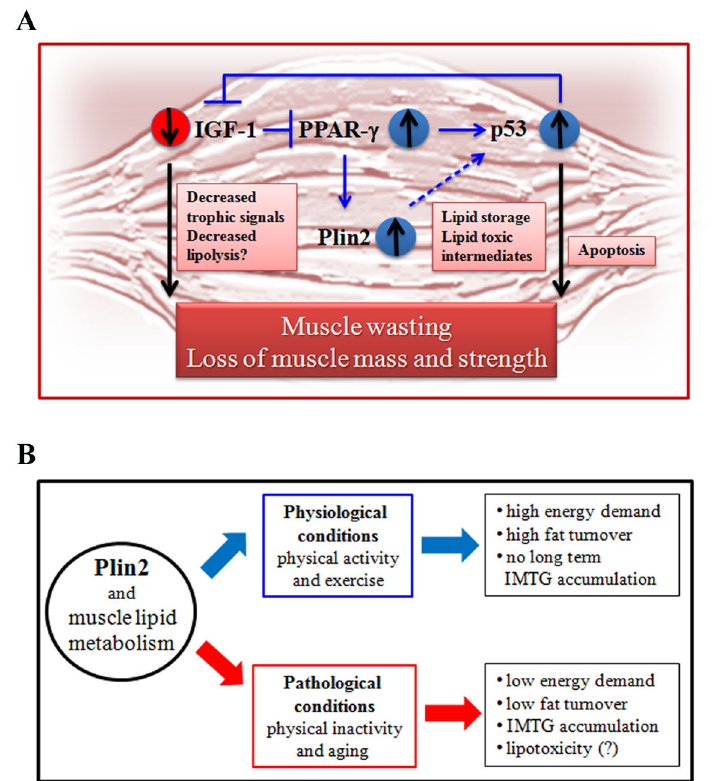
Figure 3. Schematic representations of the hypothetical role of Plin2 in muscle aging. ( A ) Proposed mechanism of action. Circled arrows indicate increased or decreased expression with aging. Plin2 could impact on p53 activation likely through indirect mechanisms (dashed arrow) possibly including the spill over of toxic lipid intermediates. ( B ) Hypothetical role of Plin2 in muscle physiology and